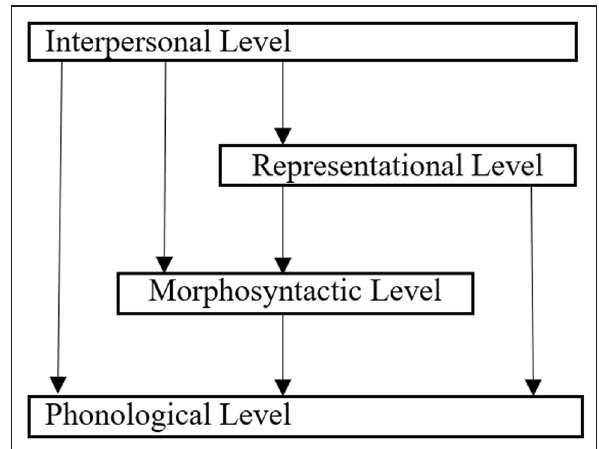
Figure 2: Internal structure of the Grammatical